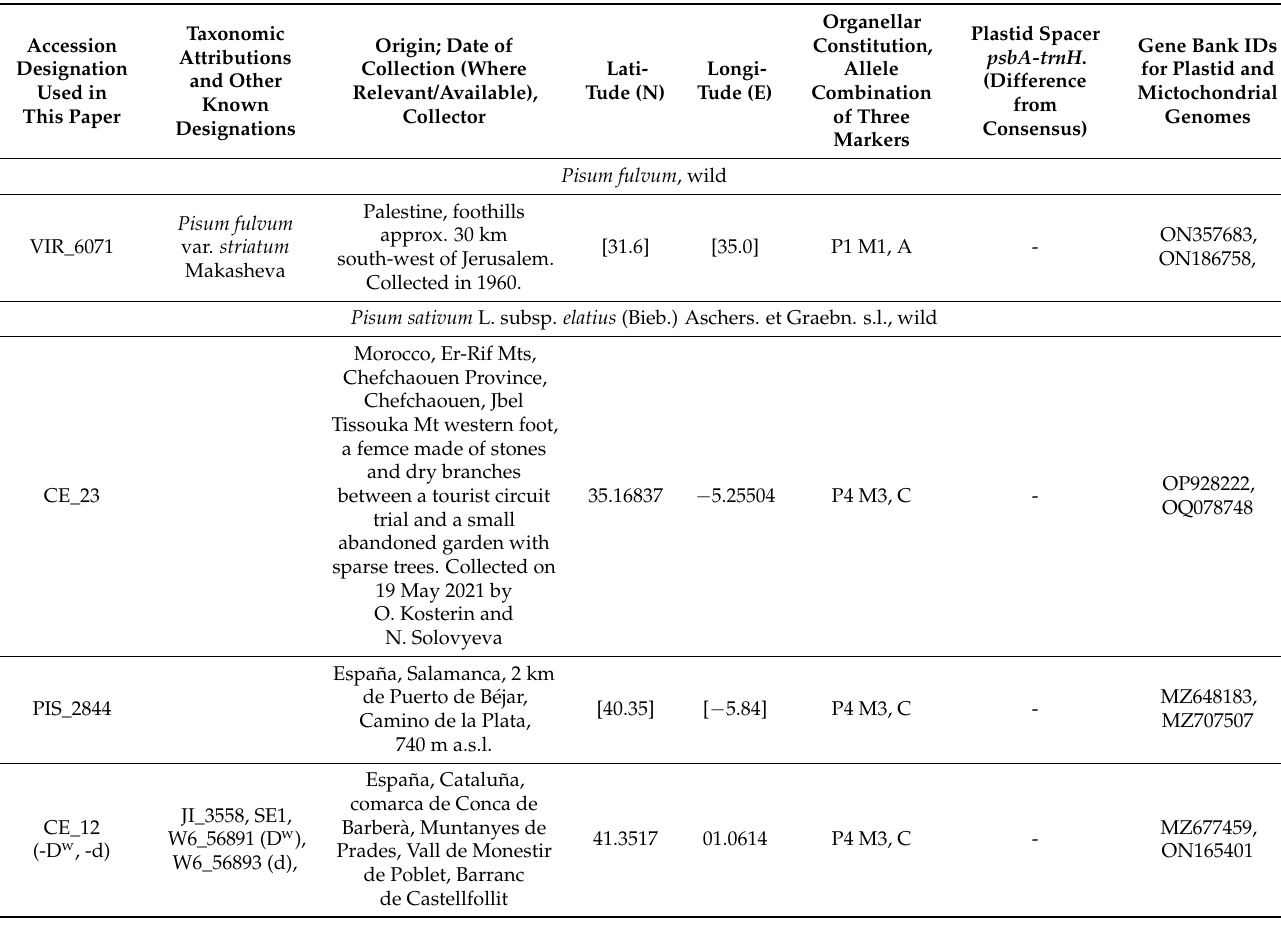
Table 1. Information on the pea accessions (in geographic order) from which the plastid and mito- chondrial genomes were sequenced in this study, with accompanying information, including their origin (with coordinates in square brackets if reconstructed), their combination of three molecular markers, their constitution of organellar genomes with respect to main evolutionary branches accord- ing to [2], differences of the plastid psbA - trnH spacer from the consensus, and GenBank IDs of the genomes sequenced in this